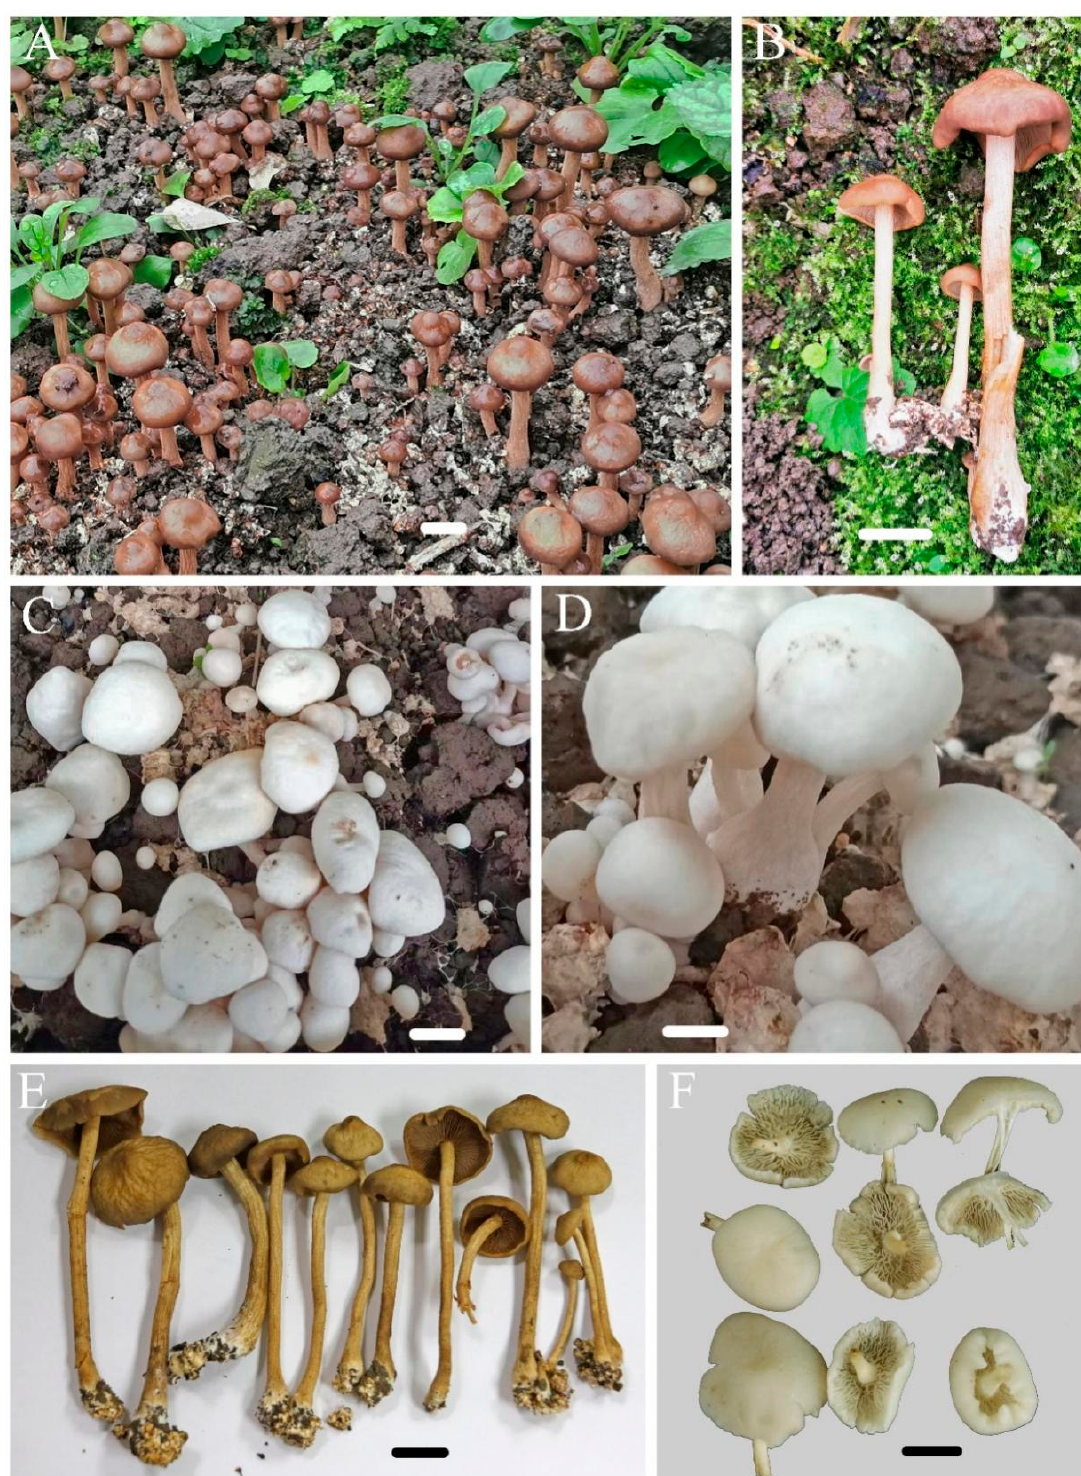
Figure 2. The macromorphological characters of Agrocybe striatipes in cultivation. ( A , B , E ) holotype (HMAS286942); ( C , D , F ) specimen HMAS286943 with pure-white fruiting bodies. Scale bar: ( A – C ) = 2 cm; ( D ) = 1 cm, ( E , F ) = 2 cm.